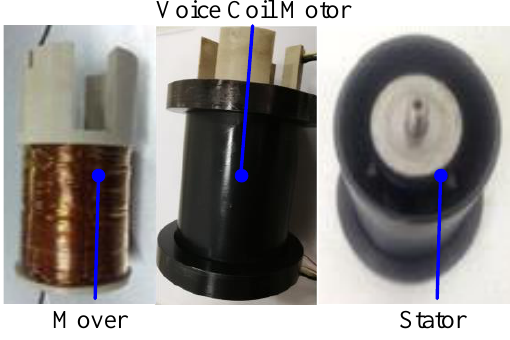
Figure 5. Detailed structure of the VCM.